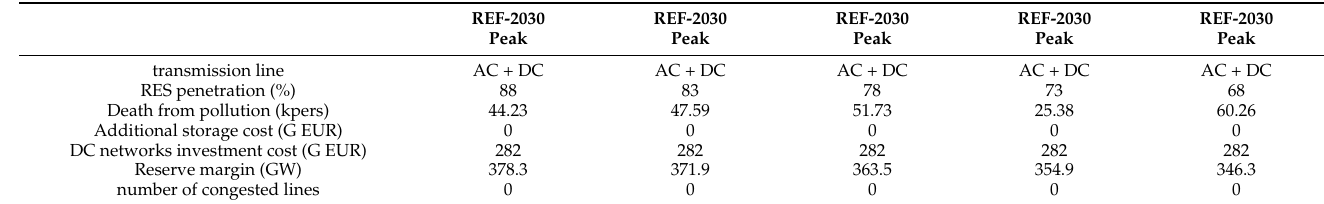
Table 4. Comparison of Different RES percentages under REF-2030 peak